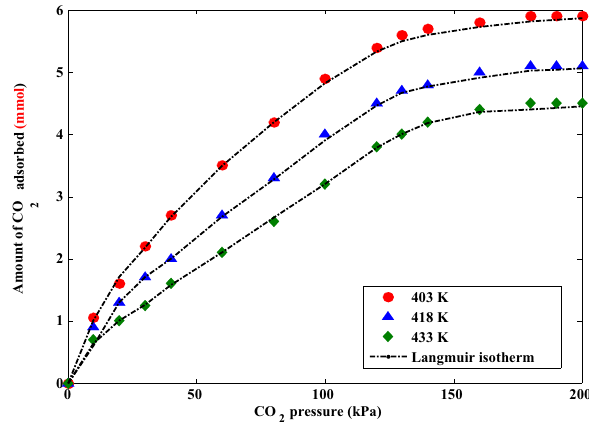
Fig. 2 Theoretical and experimental effect of moisture on the CO 2 adsorption capacity of polyaspartamide